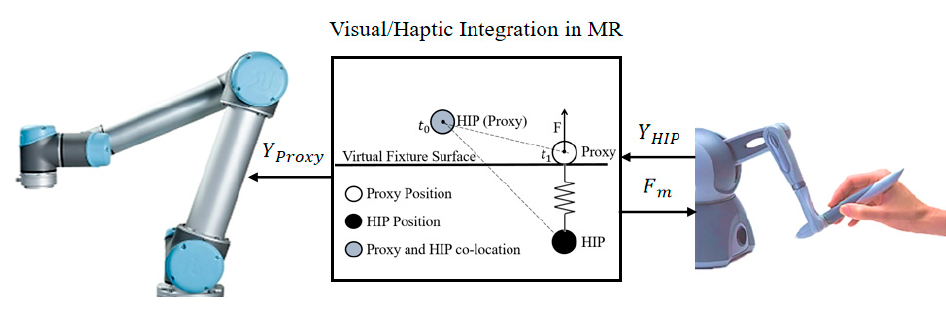
Figure 5. Block diagram of the master-controlled HIP and proxy-controlled robot architecture.